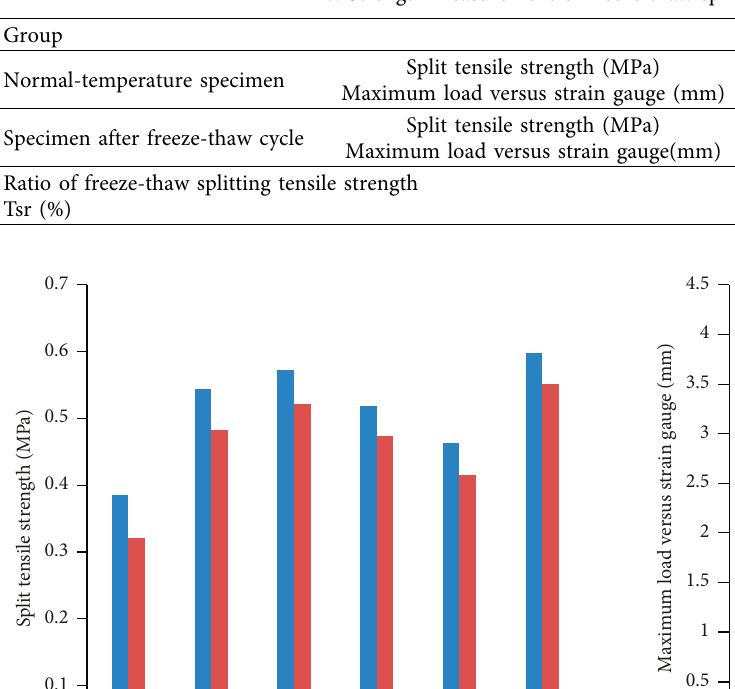
Table 6: Strength measurement of freeze-thaw split specimens in each group.